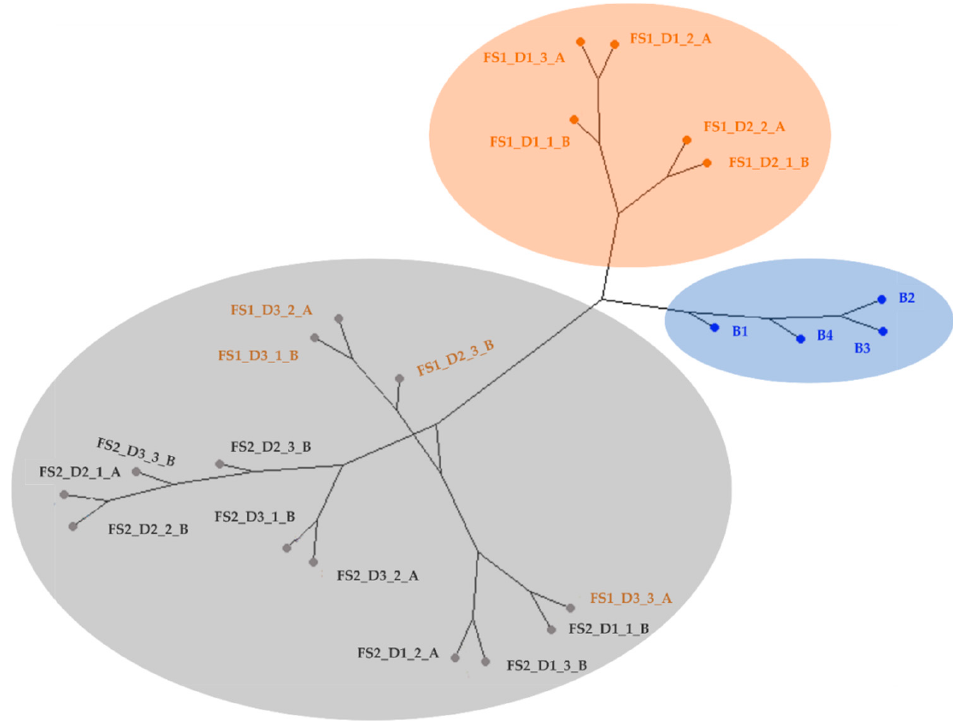
Figure 2. Dendrogram of HCA of blank (blue) and exposed armbands from FS 1 (orange) and FS 2 (grey) (D 22X1020 ), where 22 is the number of armband samples, and 1020 is the number of drift times. As can be observed in Figure 2, blank samples were grouped together (blue dots) and fully separated from the contaminated armbands. These results confirmed that the studied fire scenes produced VOCs that remained in armbands, producing differences in signals than non-exposed armbands. The second cluster (orange dots) grouped five of the nine samples of armbands from FS 1. Finally, the third cluster was divided into two sub-clusters. The first one was formed by the rest of the samples from FS 1 and the samples from FS 2 from day one. The second sub-cluster grouped together the rest of the armband samples from FS 2 (grey dots). To sum it up, the second conclusion obtained from the HCA results was that fire scenes with different characteristics (presence and